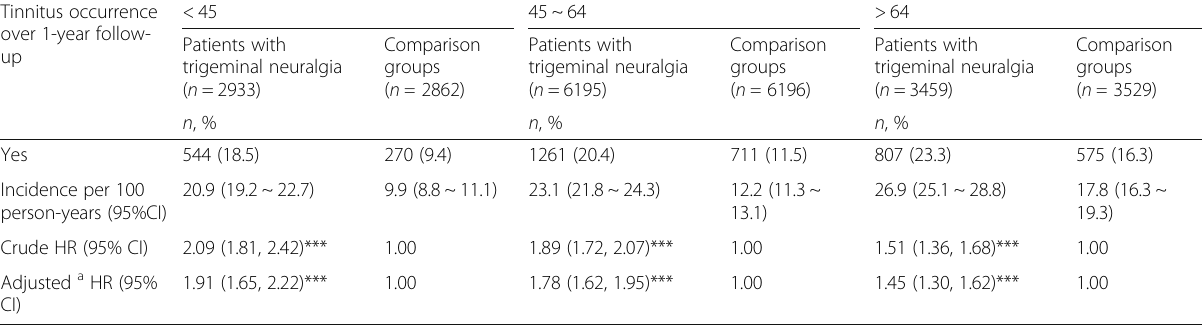
Table 4 Incidence rate, crude and adjusted hazard ratios for tinnitus among the sampled patients according to age group Tinnitus occurrence over 1-year follow-